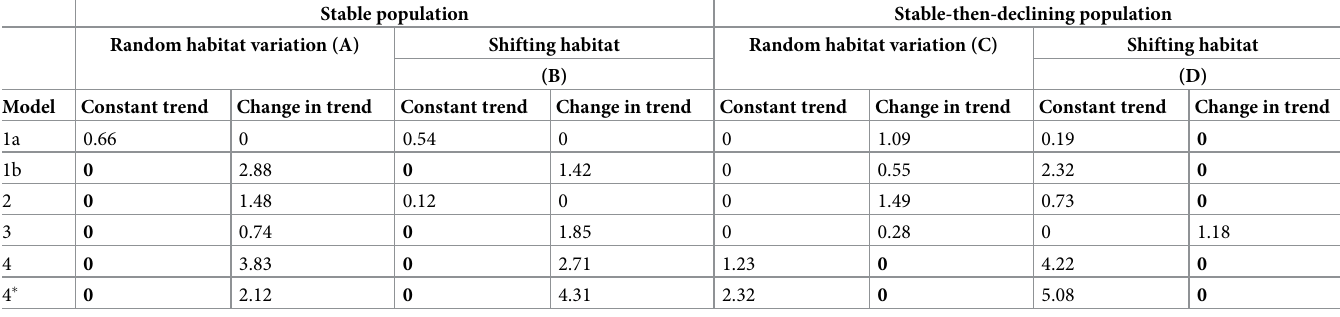
Table 2. Model comparison using difference in WAIC; a value of 0 indicates the model with greater support in each model pair; a value of less than 2.00 indicates a model with substantial